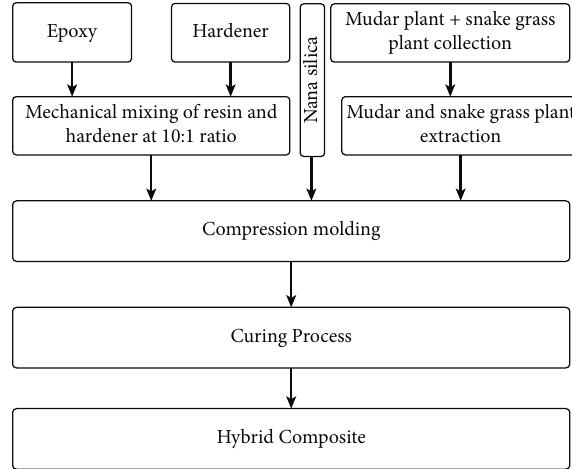
Figure 1: Composite fabrication Table 1: Properties of the fibers.